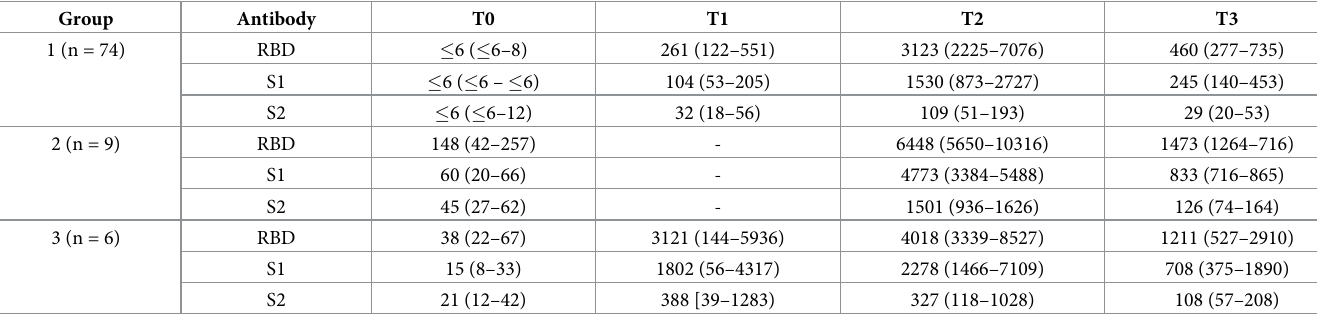
Median DF50-values (IQR) for RBD, S1 and S2 are presented at the different time-points T0 (baseline), T1 (3 weeks after first vaccine), T2 (1 month after second vaccine) and T3 (6 months after second vaccine) for group 1 (n = 74) vaccinated subjects who had no prior COVID infection, for group 2 (n = 9) vaccinated subjects who had a prior COVID infection and for group 3 (n = 6) vaccinated subjects who reported no prior COVID infection, but who showed antibodies reactivity at baseline (T0). The other antibodies (MP1, NP1 and NP2) were not reported as they were not triggered by the